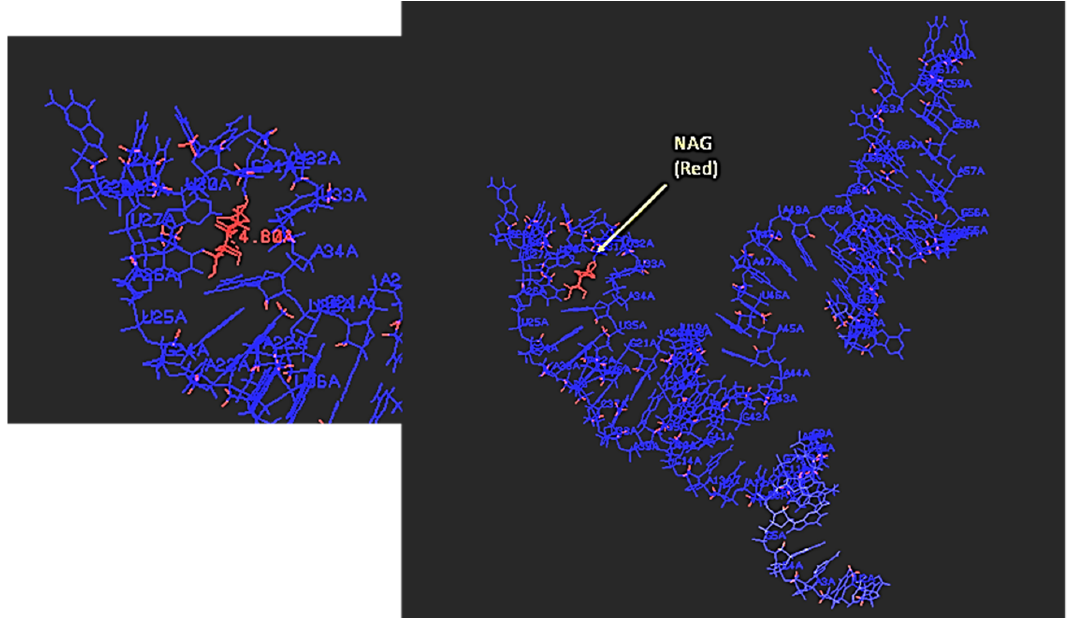
Figure 7. Static 3D model of NAG bound to the NAG-13F aptamer displayed in RasMol and showing the relative distances in Angstroms (4.8 Å for NAG as shown in the magnified left inset panel of the aptamer binding site, red text).